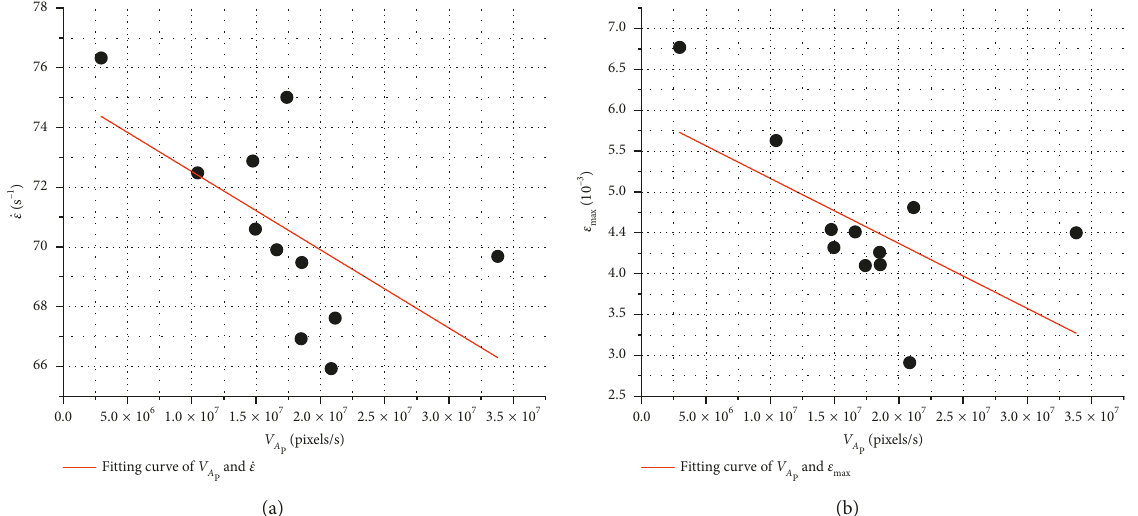
_ ε as a function of